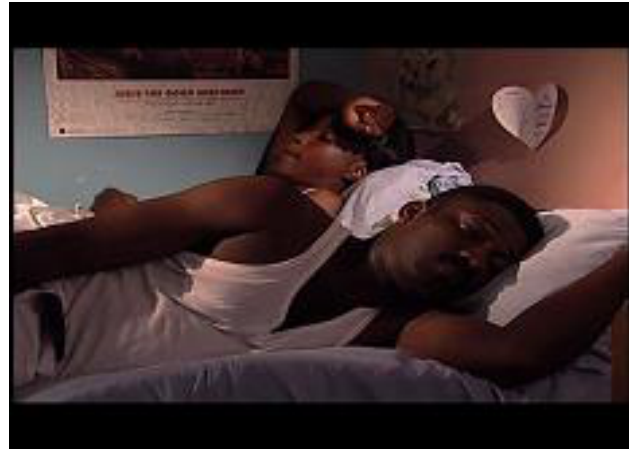
Fig. 3 Yinka in conflicted mood with his wife,